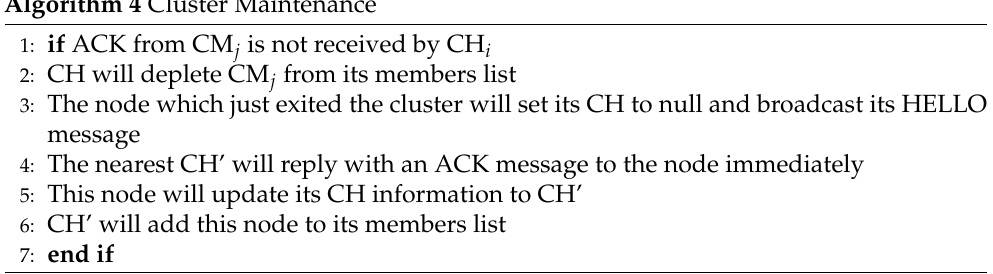
Algorithm 4 Cluster